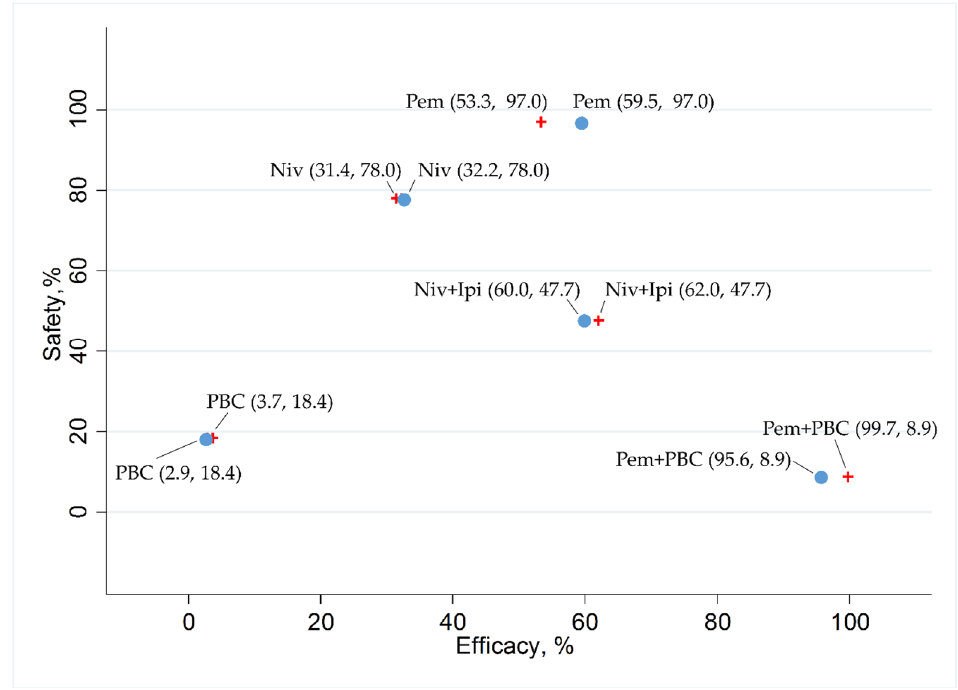
Figure 9. The surface under the cumulative ranking curve (SUCRA) of the efficacy in overall survival (OS) in a group of patients with programmed cell death ligand 1 (PD-L1) expression levels of 1% or more (presented as red crosses), in a group of patients with PD-L1 expression levels of 50% or more (presented as blue circles), and safety in any Grade 3–5 drug-related adverse events (G3–5AEs) in the overall population of the five therapeutic regimens (Niv+Ipi, Pem+PBC, Pem, Niv, and PBC). Data are presented as (SUCRA in OS and SUCRA in G3–5AEs) with each plot of the five therapeutic regimens. In terms of efficacy in patients with PD-L1 expression levels of 1% or more (presented as red crosses), Pem+PBC ranked the highest, followed by Niv+Ipi, Pem, Niv, and, finally, PBC. In terms of efficacy in patients with PD-L1 expression levels of 50% or more (presented as blue circles), Pem+PBC ranked the highest, followed by Niv+Ipi, Pem, Niv, and, finally, PBC. However, Pem ranked the highest in safety, followed by Niv, Niv+Ipi, PBC, and, finally, Pem+PBC. Niv, nivolumab; PBC, platinum-based chemotherapy; Pem, pembrolizumab; Ipi, ipilimumab.